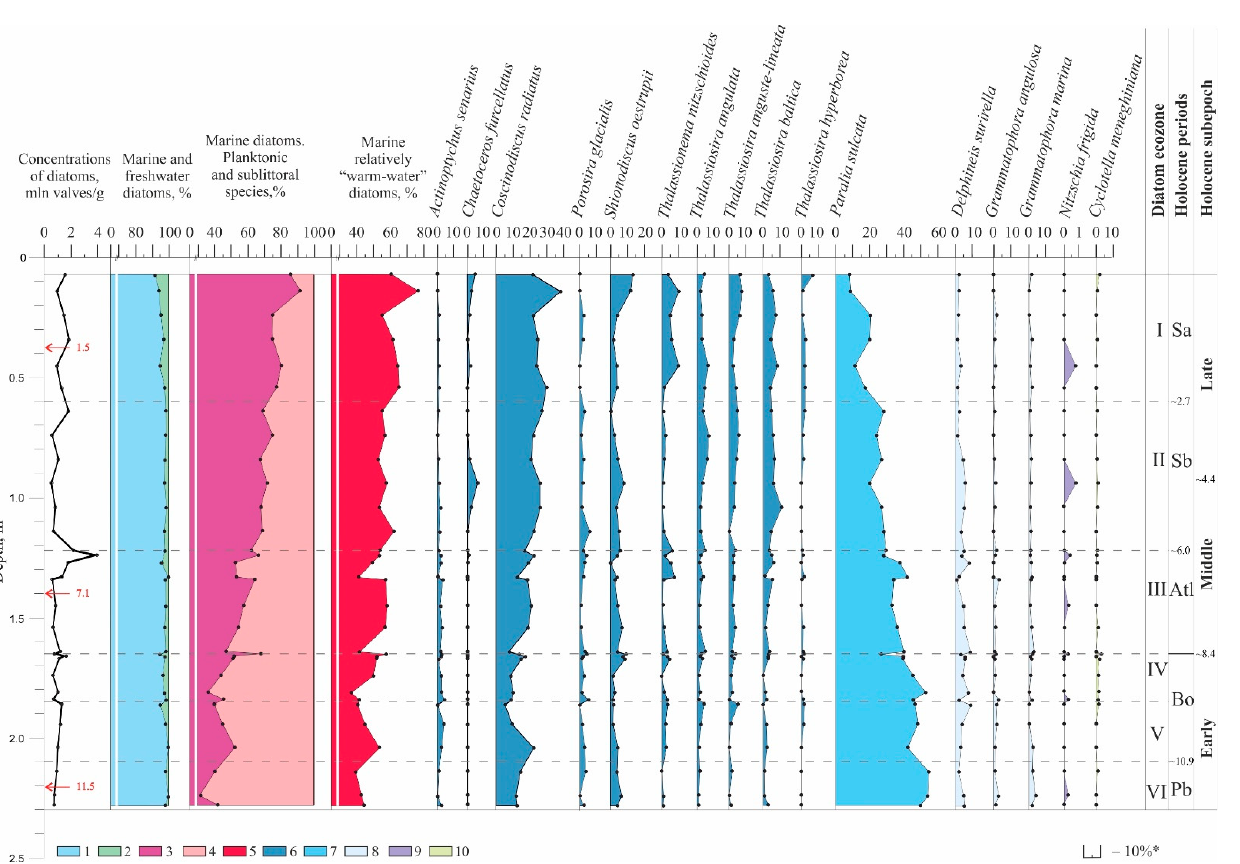
Figure 5. Diatom concentration and percentage of the main taxa in core PS-6066. 1—marine diatoms; 2—freshwater diatoms; 3—marine planktonic diatoms; 4—marine sublittoral diatoms; 5—relatively “warm-water” marine diatoms; 6—plankton neritic and pantalassic taxa; 7—meroplanktonic taxa; 8—sublittoral benthic taxa and periphyton; 9—sea ice taxa; 10—freshwater taxa. Diatom percentage ticks are 10%, except for Nitzschia frigida (1%). The dates in cal kyr BP are indicated in red in the diatom concentration column. The Holocene stages and diatom ecozones are indicated in the right margin. Age boundaries from the correlations are in black.